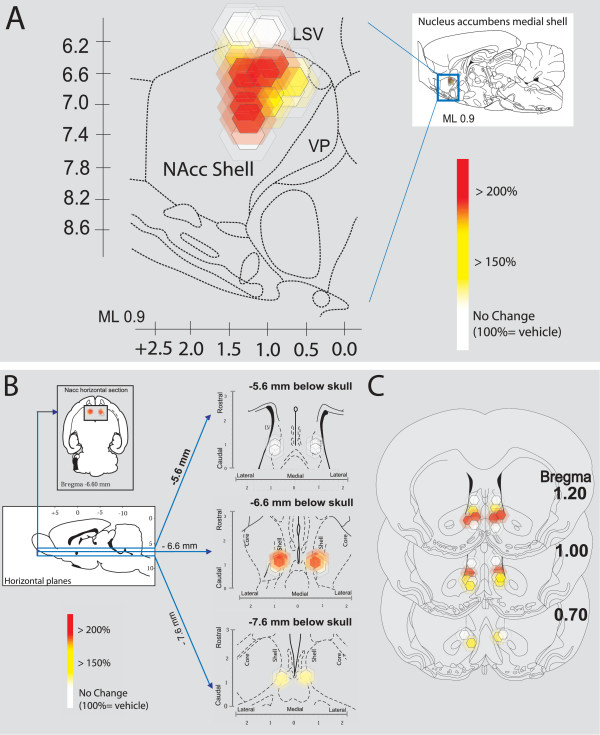
Fos plume maps of CRF (500 ng) amplification of cue-triggered increases in lever pressing. Fos plume maps of functional localization: CRF effects on cue-triggered incentive salience. Sagittal (A), horizontal (B), and coronal maps (C) show each Fos plume as colored symbol in medial shell of nucleus accumbens. Color depicts magnification effect of CRF (500 ng) microinjection at that site on peaks of lever pressing triggered by a 30 sec auditory CS+ previously associated with sucrose reward (within-subject percentage elevation of CRF versus vehicle in the same rat; 100%=vehicle). Size of central symbol depicts radius of intense Fos elevation; size of surrounding halos depict outer radius of moderate Fos elevation. For the sagittal map, bilateral accumbens sites from left and right sides of each rat brain are collapsed together into one combined sagittal map of accumbens for simplicity. Maps adapted from Paxinos and Watson [46].